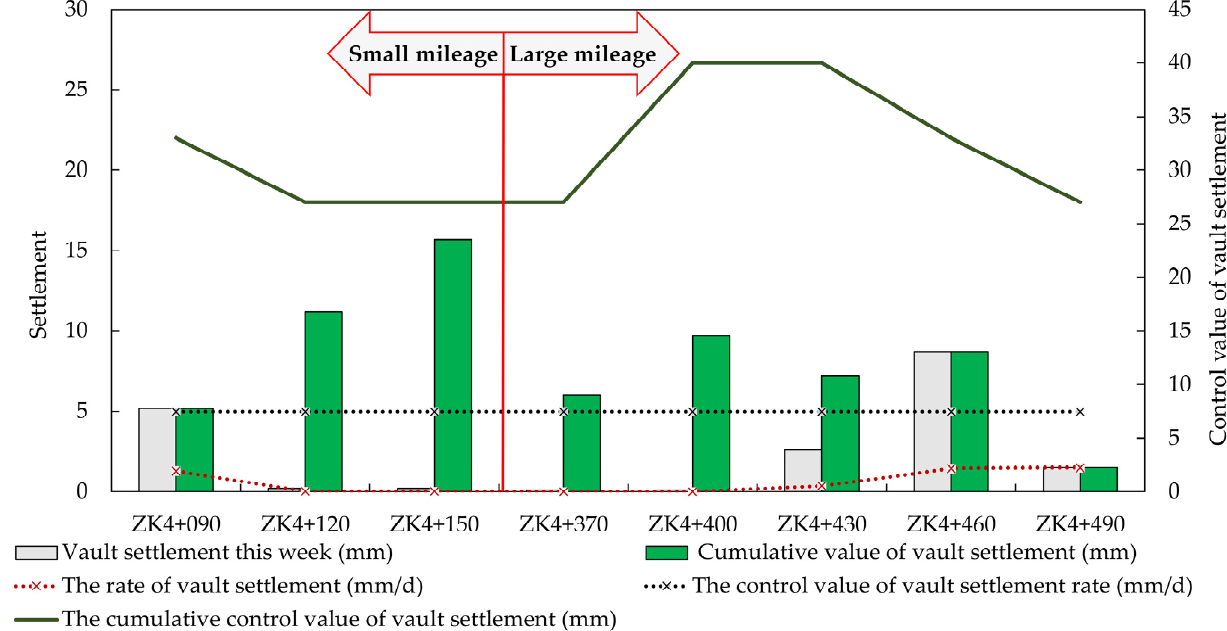
Figure 5. Variation curve of the cumulative measured value of the vault settlement with the